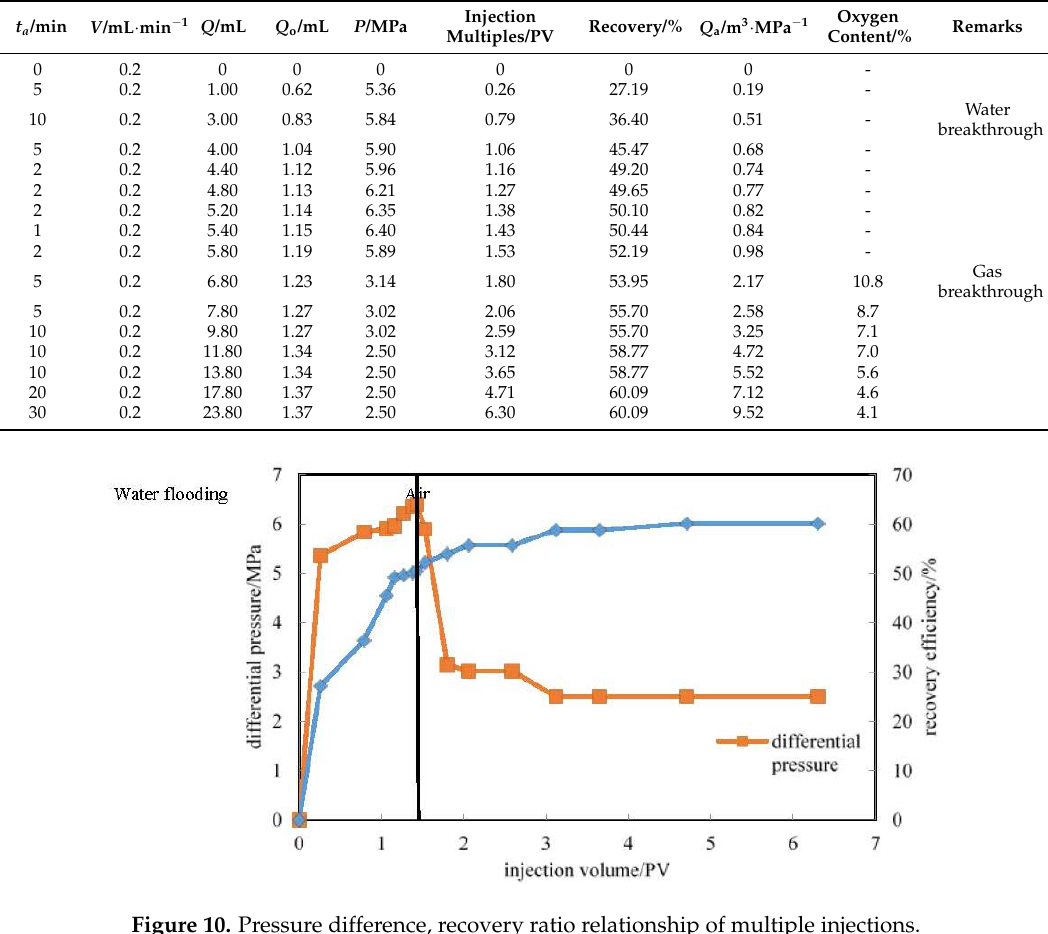
Table 14. Third group experiment: first water flooding followed by air injection experiments.